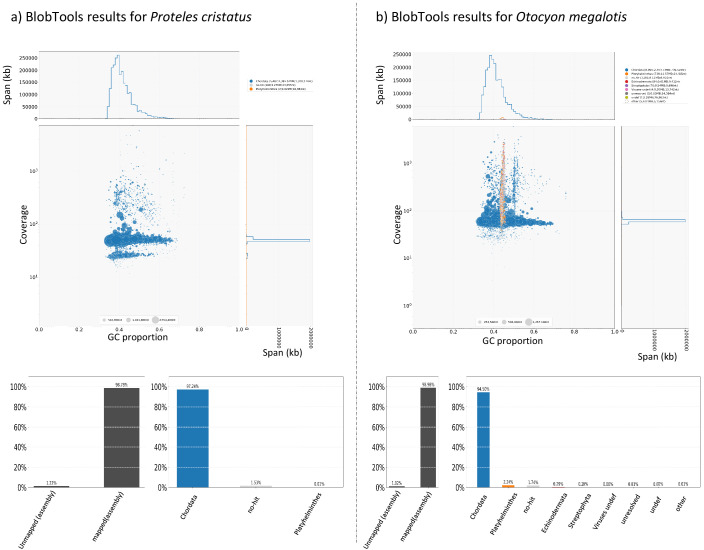
Graphical representation (BlobPlot) of the results of contamination analyses performed with BlobTools for (a) the aardwolf (Proteles cristatus cristatus) and (b) the bat-eared fox (Otocyon megalotis megalotis) genome assemblies.